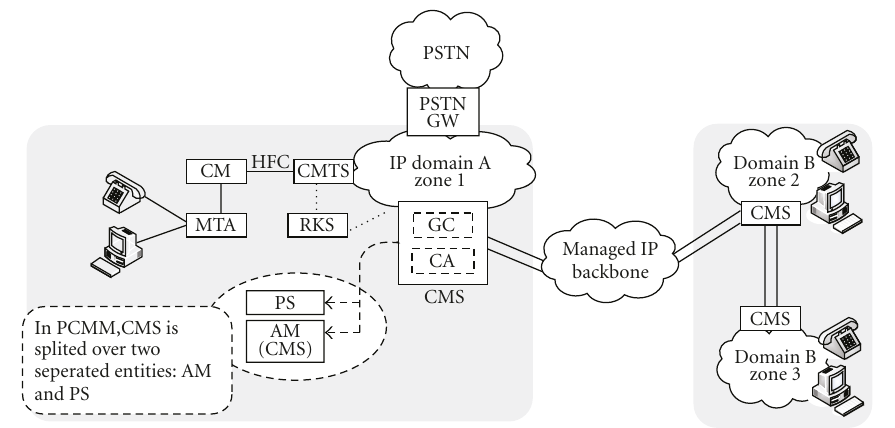
Figure 4: PacketCable 1.x